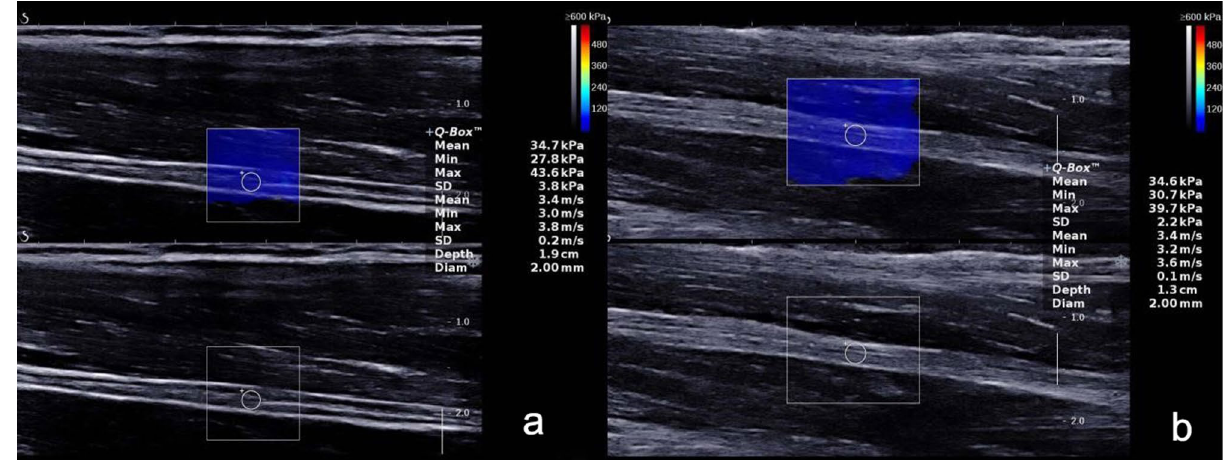
Figure 2. In the relaxed position, the shear wave velocity of the right ( a ) and left ( b ) median nerve forearm